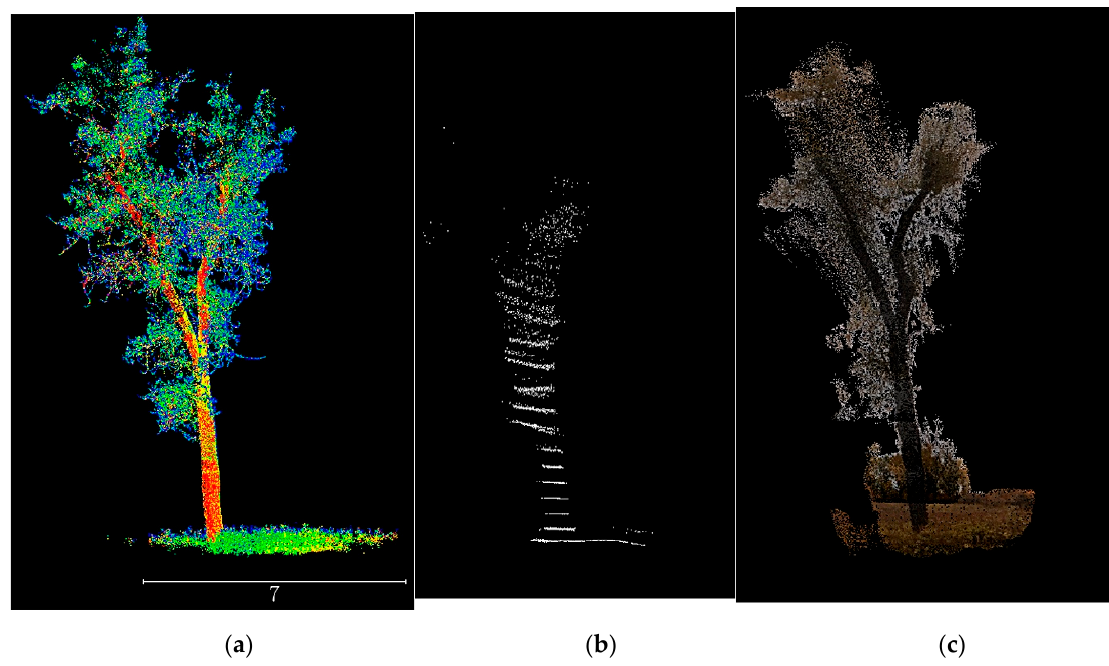
Figure 9. Example tree point clouds from ( a ) TLS scans, ( b ) Leddar-only point clouds, and ( c ) fusion-based dense point clouds.